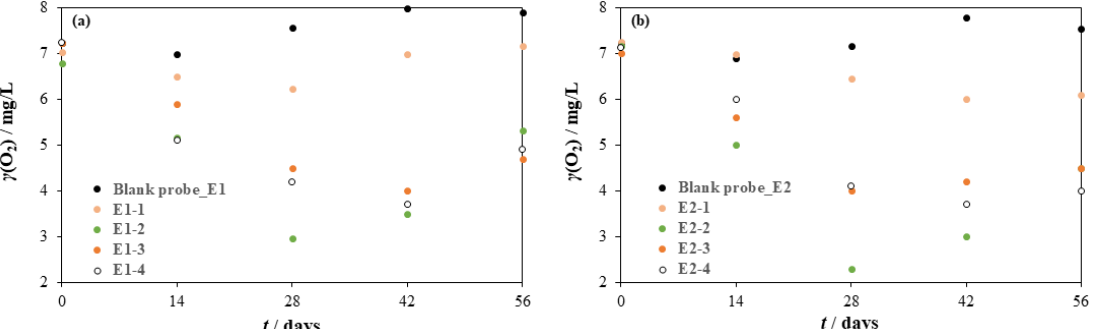
Figure 5. Change of CFU of bacteria ( a ) and fungi ( b ) in experiments E2 during 56 days of biodegradation experiments.